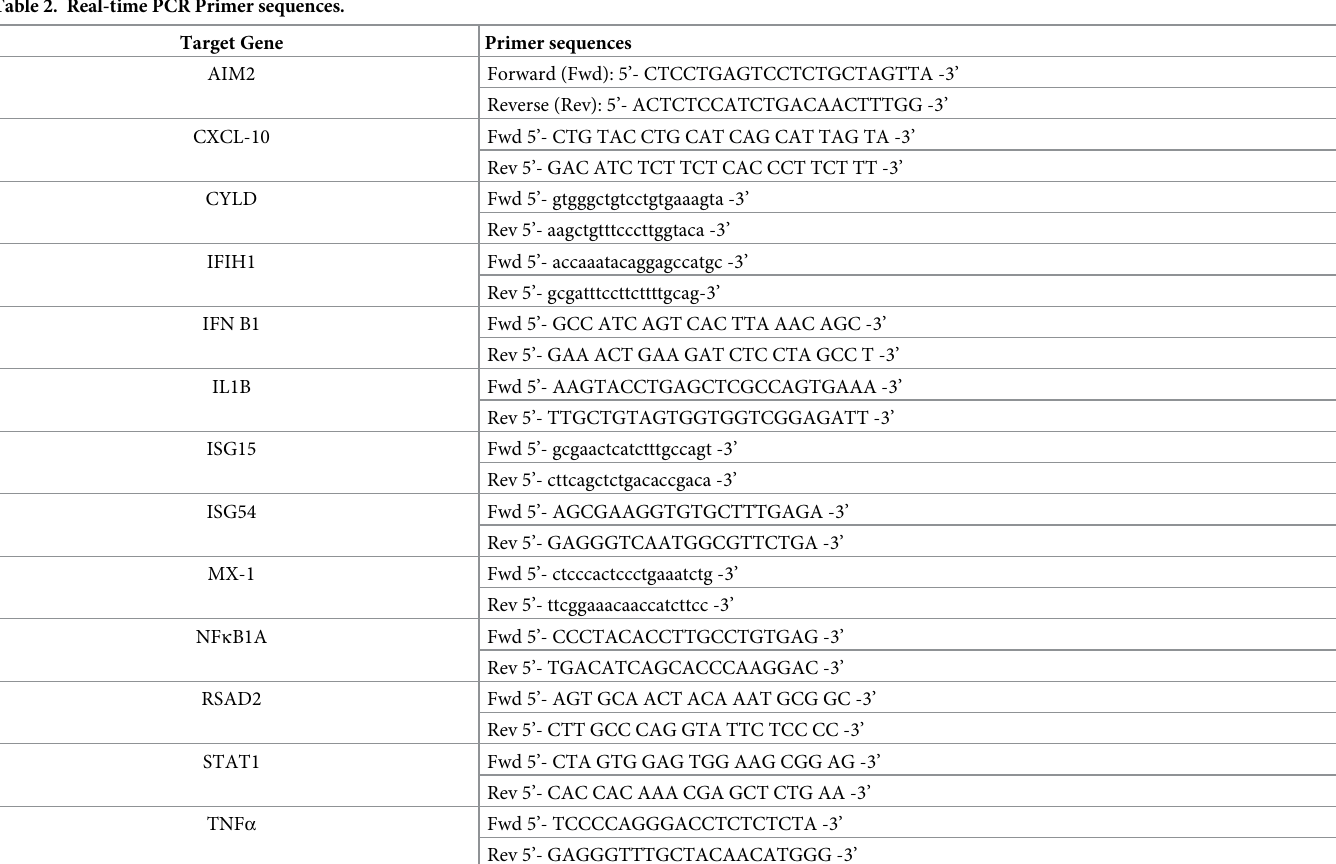
Table 2. Real-time PCR Primer